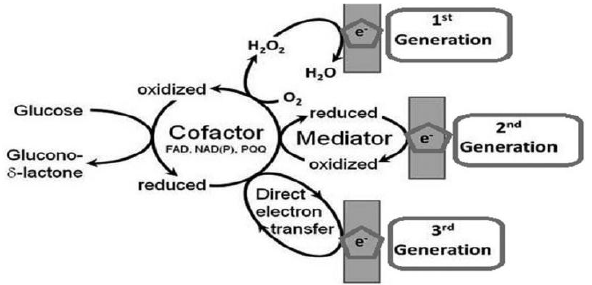
Figure 3. A schematic of the reactions governing different glucose sensor generations [23].